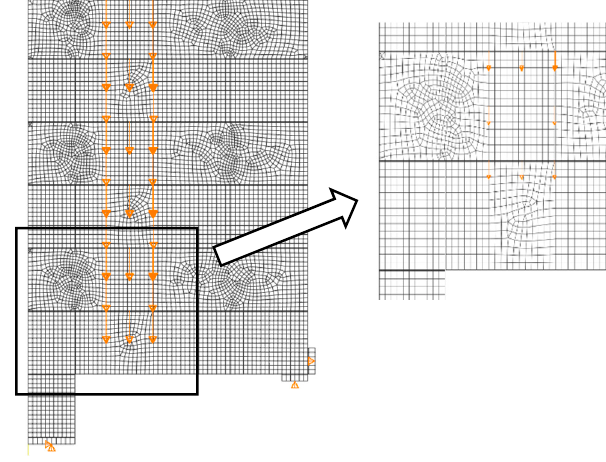
Figure 5. Overview of the 2D reference model (ABAQUS / Standard): Loads and boundary conditions and a detail of FE meshing.